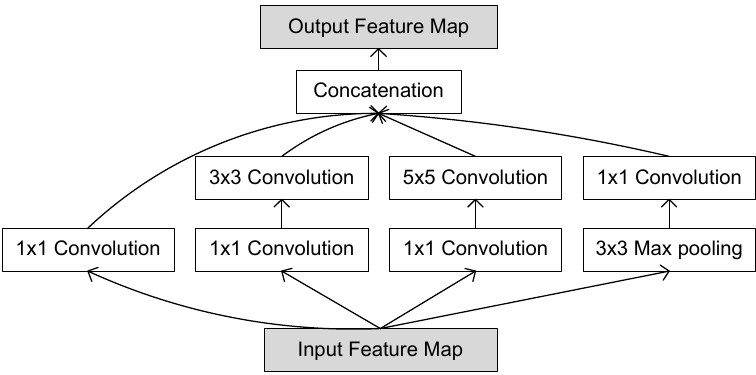
Figure 1. Architecture of the inception module of GoogLeNet.